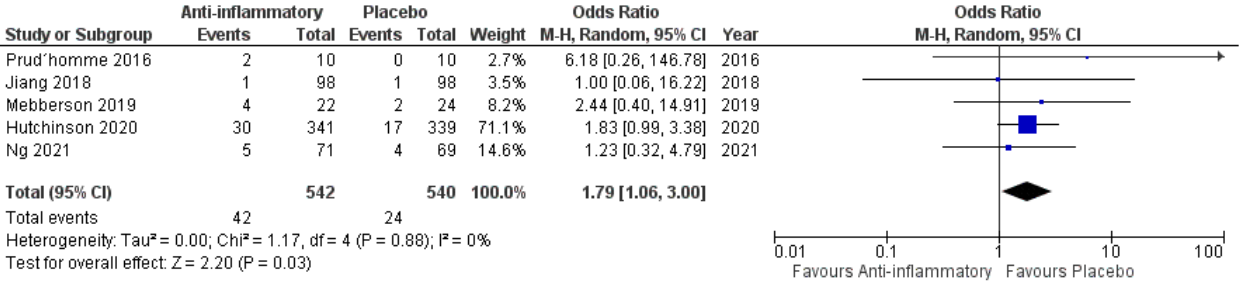
Figure 3. Forest Plots displaying OR and 95% CI estimates for mortality in studies [28 – 32] evaluating anti-inflammatory therapies compared to placebo in cSDH patients treated surgically or conservatively. Squares represent the odds ratio; the bigger the square, the greater the weight given because of the narrower 95% CI. Diamond represents the odds ratio of the overall data.